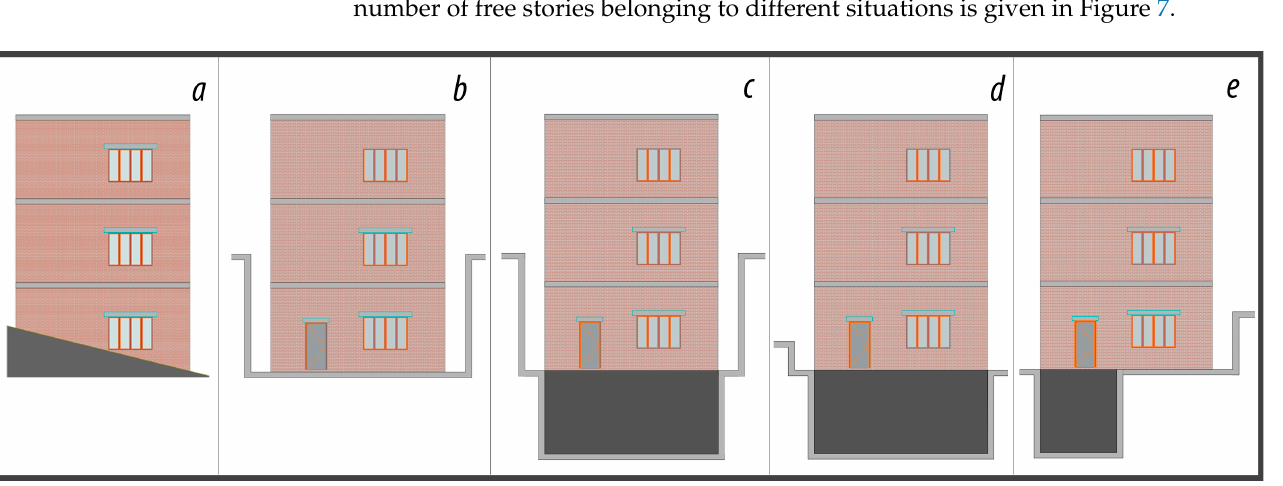
Figure 7. Specification of the number of stories (for the 3-stories buildings): ( a ) Hill slope effect, ( b ) Below ground level, ( c ) Below ground level and has a basement, ( d ) Having a basement in the building, ( e ) Having partial basement in the building.